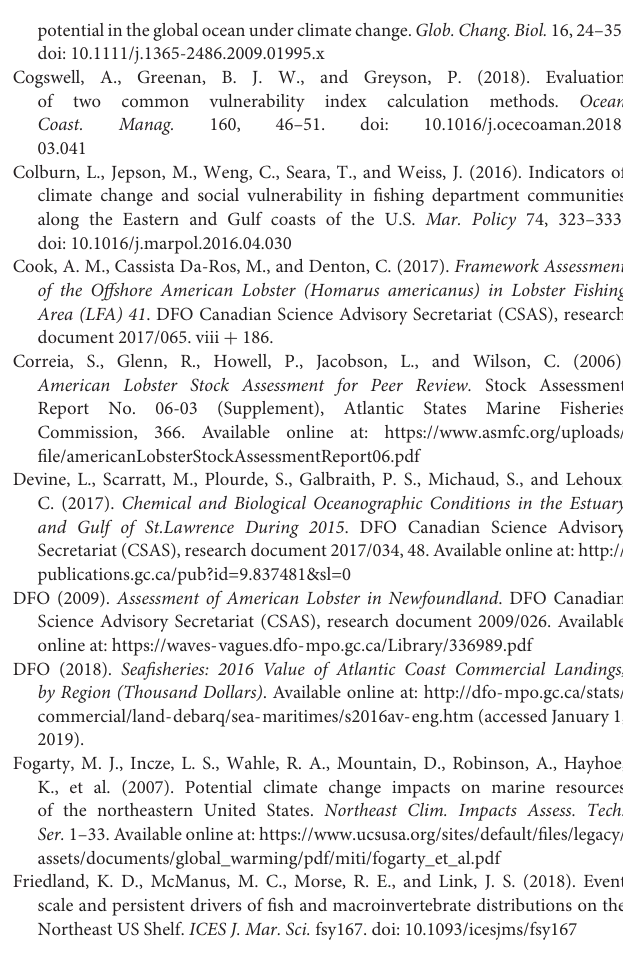
Figure S1 | Comparison of BNAM and CM2.6: seasonal changes in bottom temperature from two ocean models. The magnitude of temperature change varies between models, so they have been plotted on different color scales, however, overall patterns are similar. (A) Projected change in summer (July, August, and September) bottom temperature (BNAM). (B) Projected change in summer bottom temperature (CM2.6). (C) Projected change in winter (January, February, and March) bottom temperature (BNAM). (D) Projected change in summer bottom temperature (CM2.6). Figure S2 | The Coastal Infrastructure Vulnerability Index (CIVI) for Small Craft Harbor locations. The scoring of 1(low vulnerability) to 5 (high vulnerability) has been grouped into three categories and then presented in the pie charts for each Lobster Fishing Area (LFA). Figure S3 | Sub-indices of the Coastal Infrastructure Vulnerability Index (CIVI) for Small Craft Harbor locations are as follows: (1) Environmental Sub-Index (ESI), (2) Infrastructure Sub-Index (ISI), and (3) Socio-Economic Sub-Index (SESI). The scoring of 1 (low vulnerability) to 5 (high vulnerability) has been grouped into three categories and then presented in the pie charts for each Lobster Fishing Area